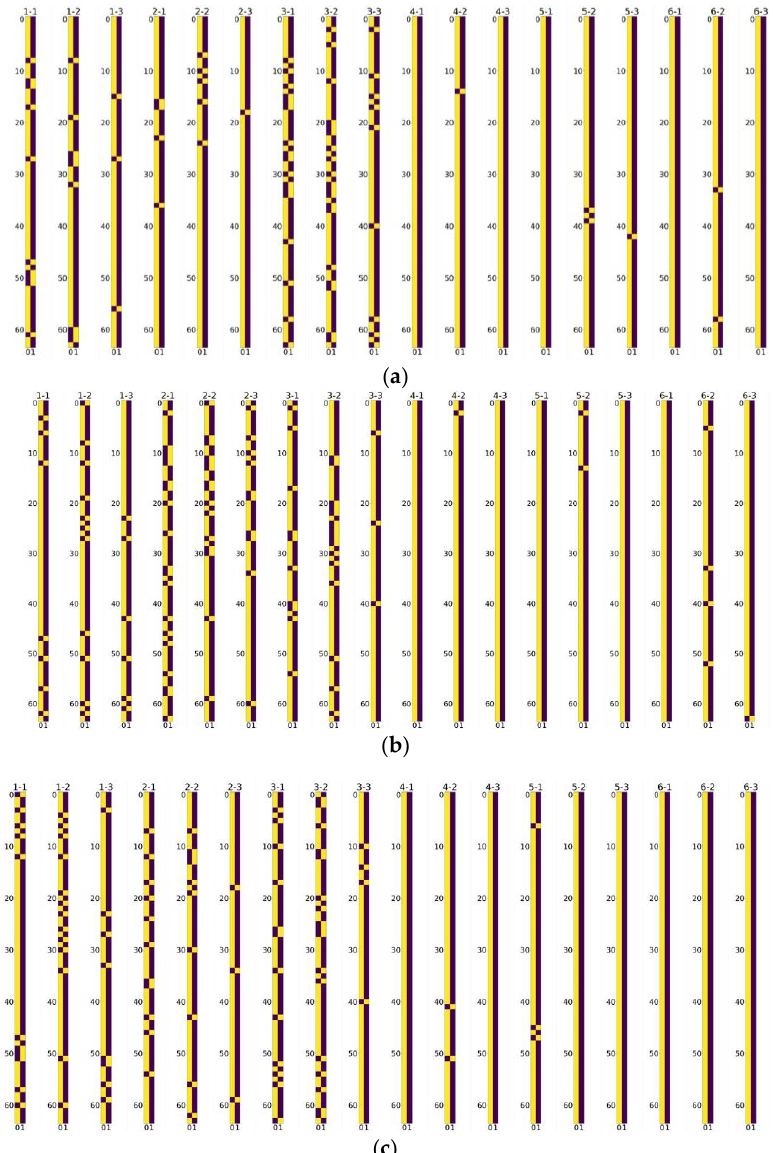
Figure 8. Visualization of the selective channel matrixes, where yellow denotes 1 and brown denotes 0 in the figures. X - Y denotes the SCM for the Y -th layer in the X -th SCPM. ( a ) Channel selection matrixes in SCPN of upscale factor 2. ( b ) Channel selection matrixes in SCPN of upscale factor 3. ( c ) Channel selection matrices in SCPN of upscale factor 4.